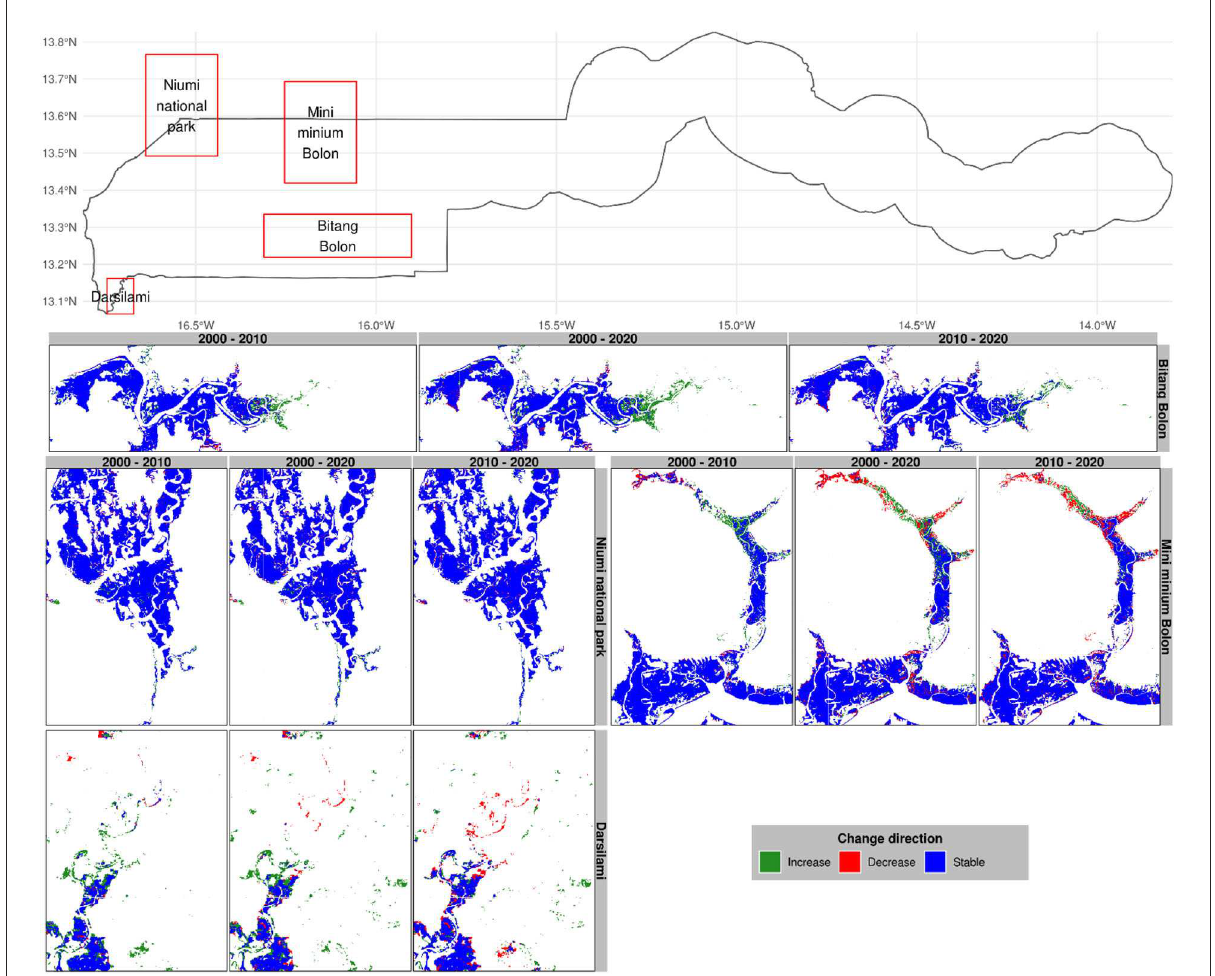
FIGURE7 Change direction in selected mangrove sites of The Gambia based on harmonic modeling and classification of Landsat and MODIS time series. These maps are snapshots of Bitang Bolon, Mini Minium Bolon, Niumi national park, and